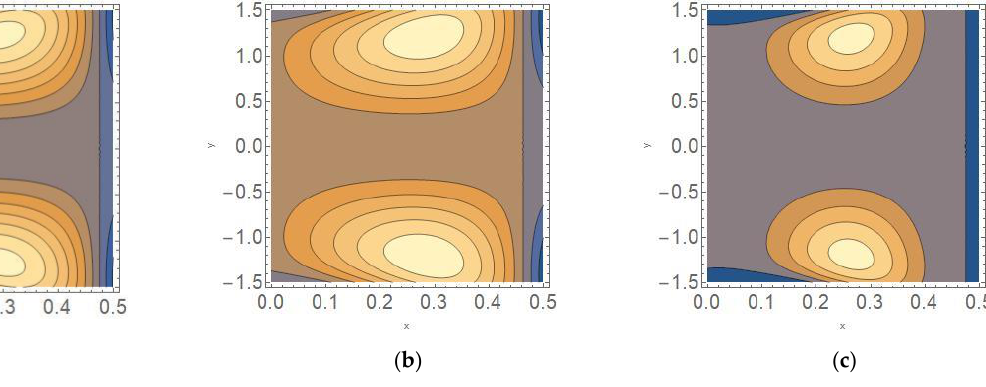
Figure 9. ( a - c ). Streamlines for ( a ) Da = 10, ( b ) Da = 15, ( c ) Da = 20 G rF = 0.5, N CT = 0.7, N TC = 0.7, N b = 0.5, N t = 0.5, P r = 7, M = 0.5, λ 1 =